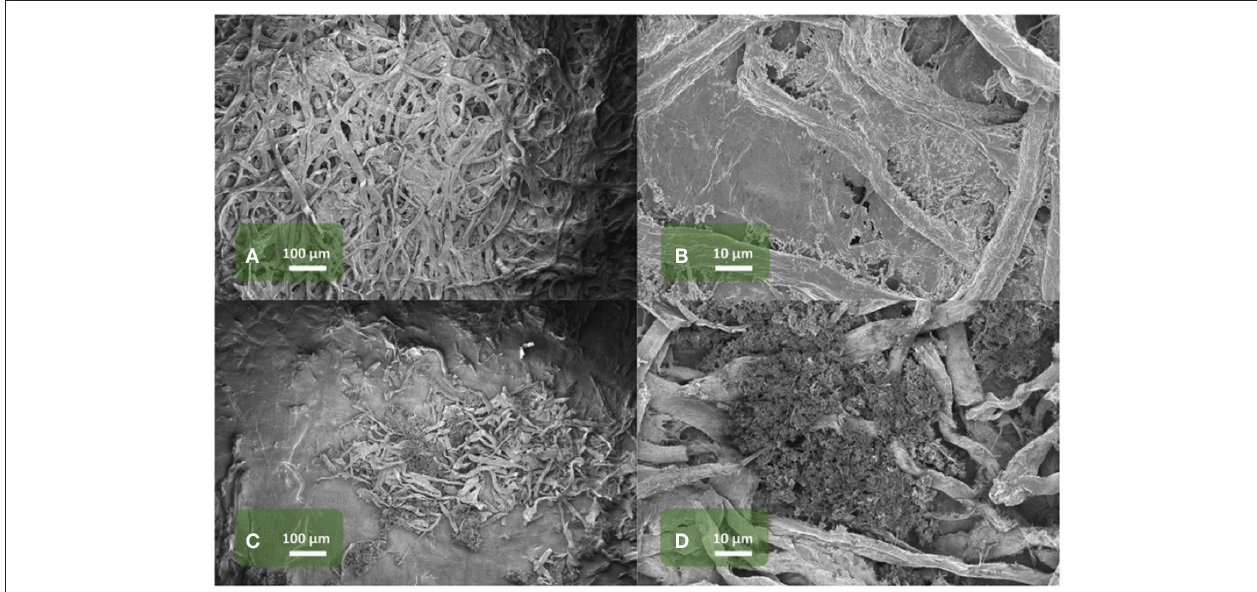
FIGURE 4 | SEM micrographs of a disassembled Li@CNW electrode, cycled in the IL-based electrolyte: The top surface of the CNW, i.e., the side which is in contact with the separator, is shown in (A,B) at different magnifications. The top surface of the Li foil, i.e., the side which is in contact with the CNW, is shown in (C,D) at different